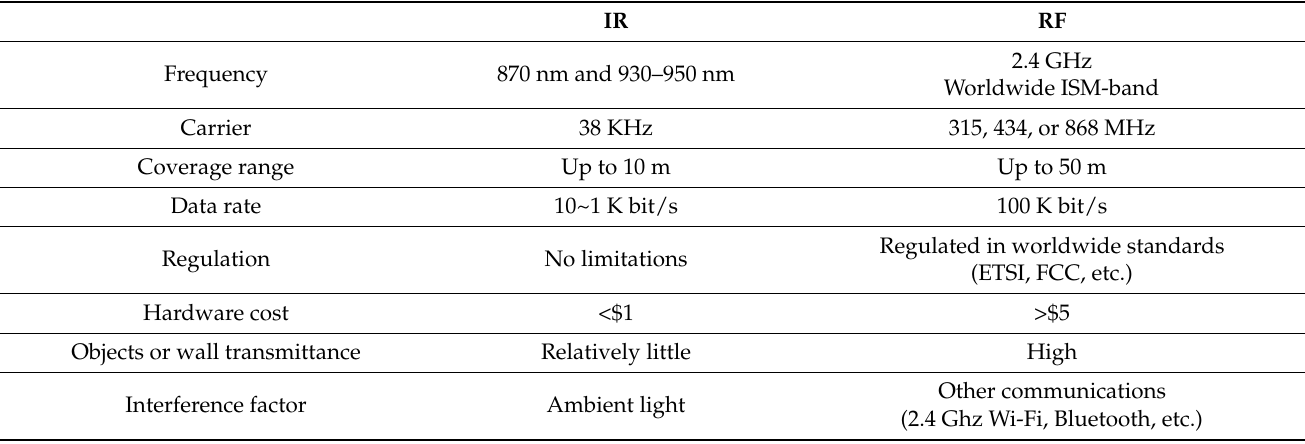
Table 1. Comparison of IR and RF remotes [26,28].